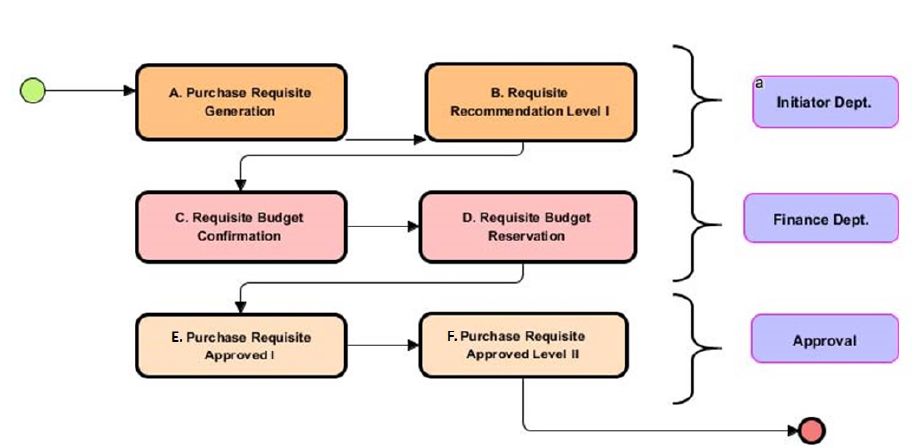
Figure 1. Procurement life